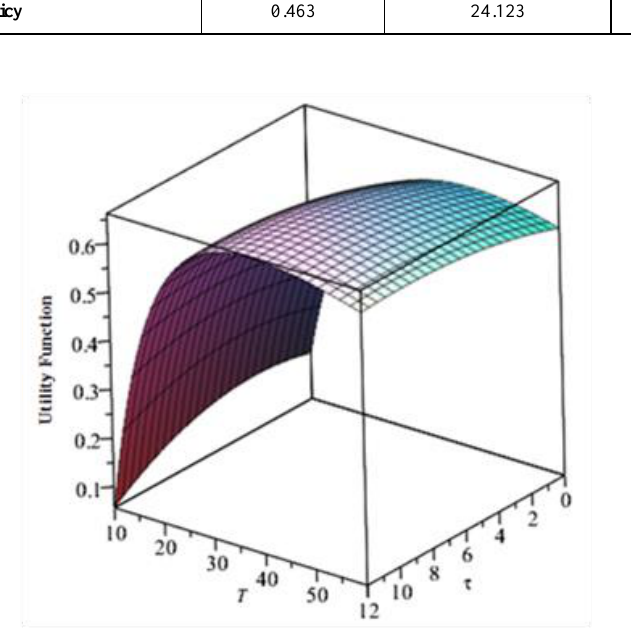
Figure 3. Concavity plot under field-testing (FT) release time policy